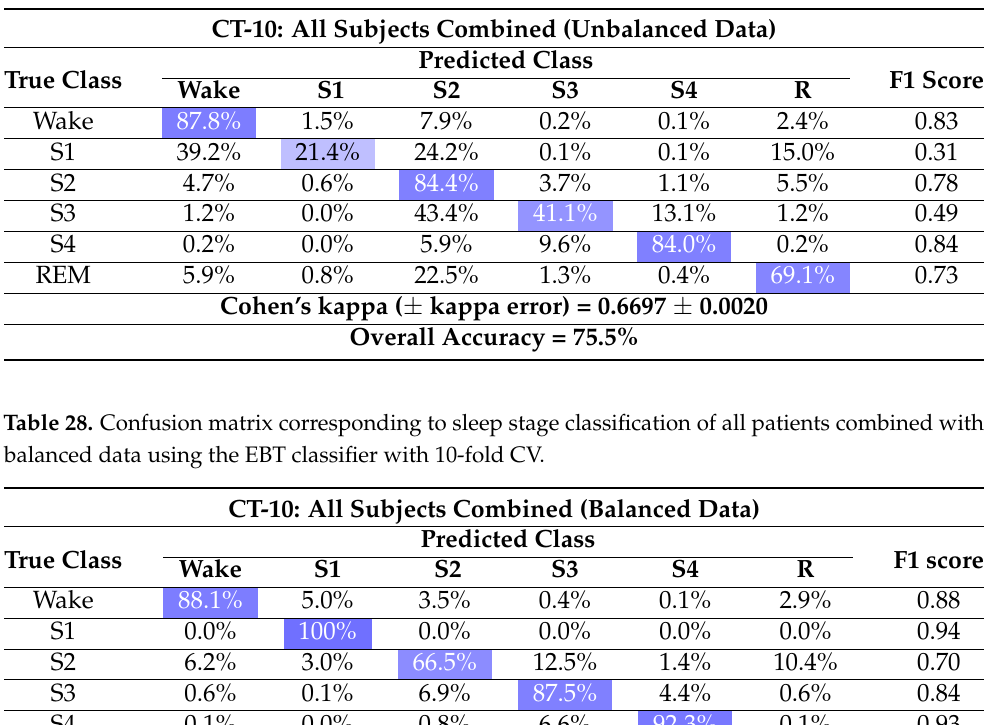
Table 27. Confusion matrix corresponding to sleep stage classification of all subjects combined (healthy + seven disordered) with unbalanced data using the EBT classifier with 10-fold CV.